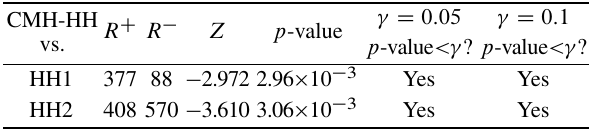
Table 9 Statistical analysis of Wilcoxon’s rank-sum test. CMH-HH vs.